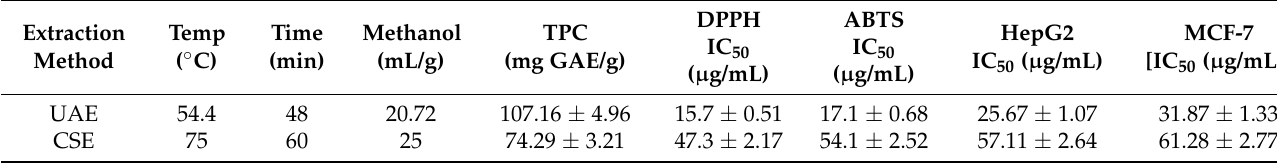
Table 7. Comparison of UAE and